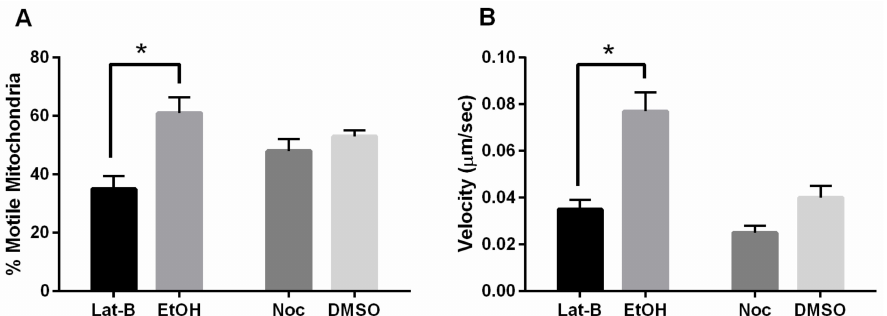
Figure 3. Percent motility and velocity of mitochondria in cells overexpressing FszB-GFP and disrupted cytoskeleton. ( A ) Disruption of the actin cytoskeleton decreases the percent of motile mitochondria ( p = 0.0016), while disruption of the microtubules has little e ff ect. ( B ) Disruption of the actin cytoskeleton significantly decreases velocity ( p = 0.0005). n = 50 cells, * indicates